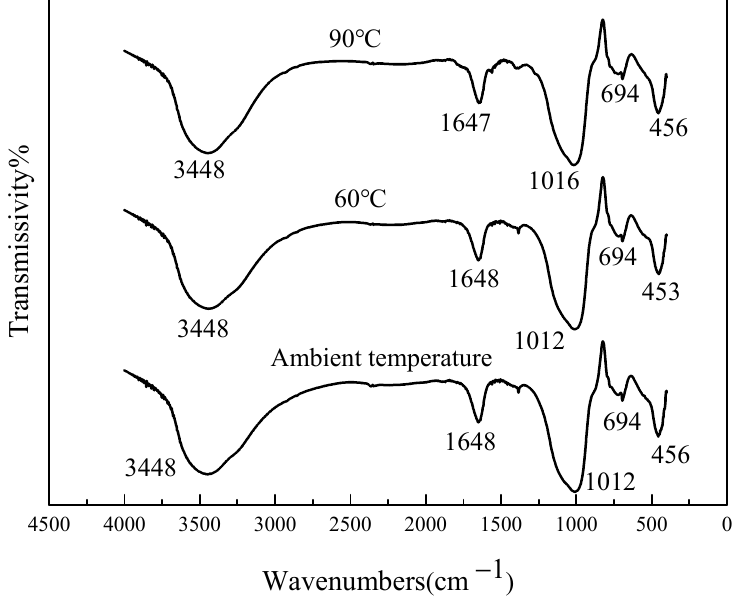
Figure 11. FTIR curves of HMGC under different curing temperatures.